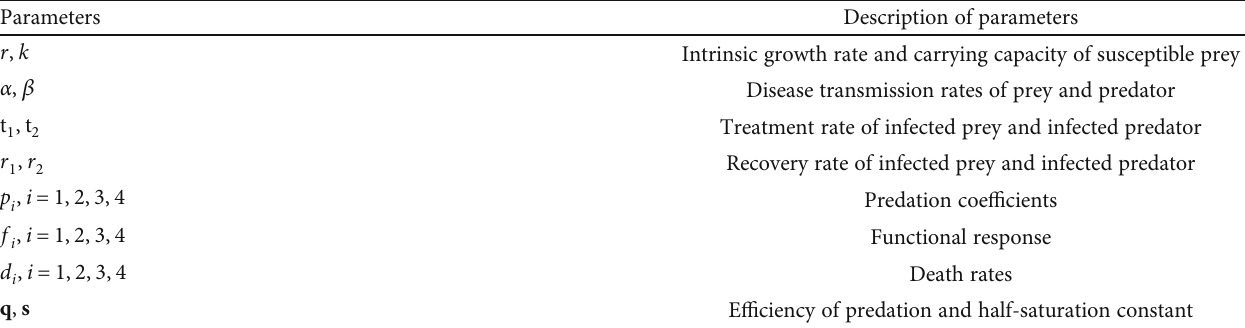
Table 3: Notations and description of